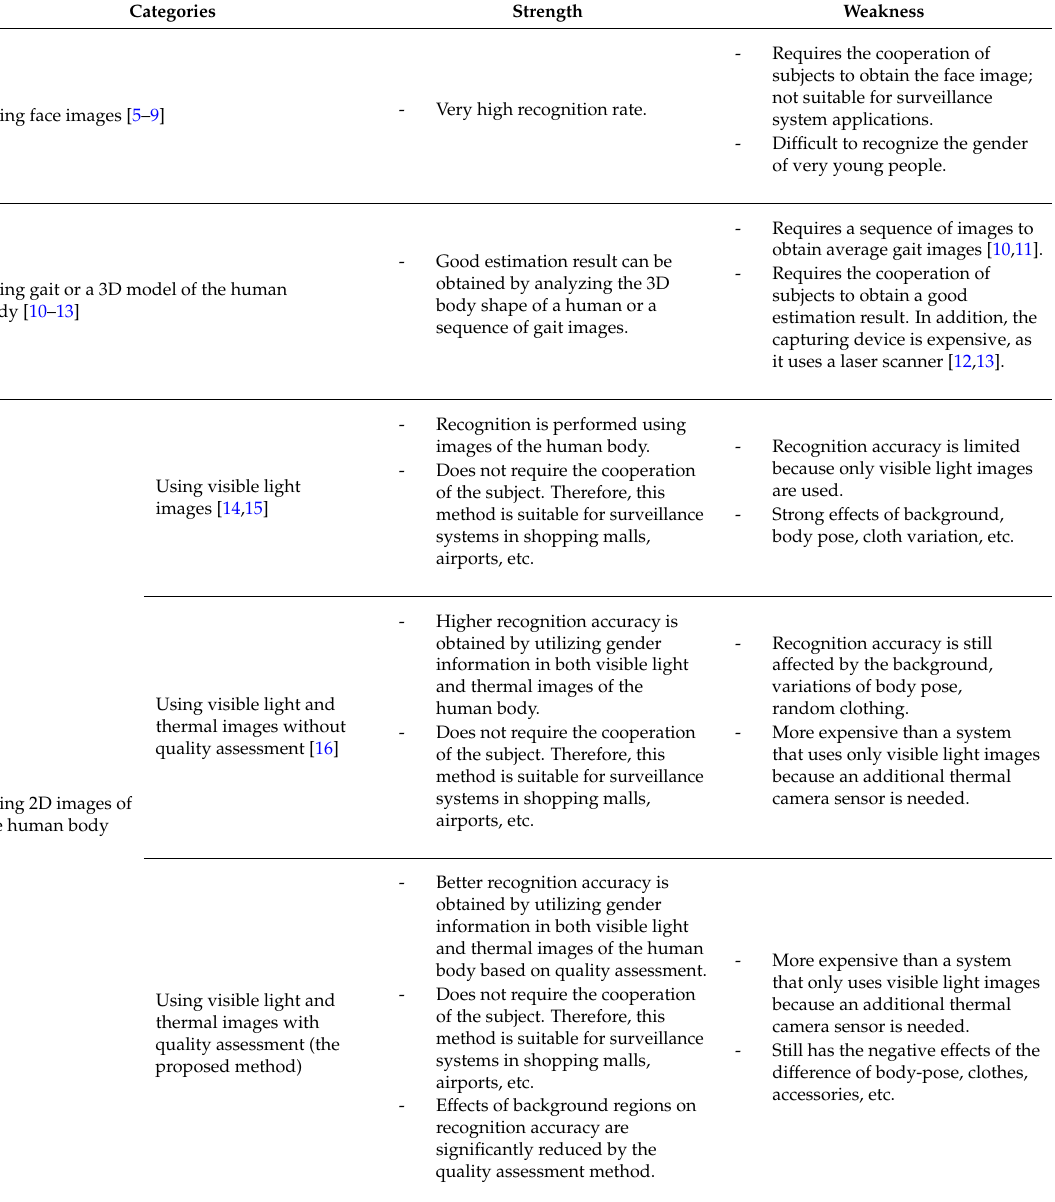
Table 1. Summary of previous studies on image-based gender